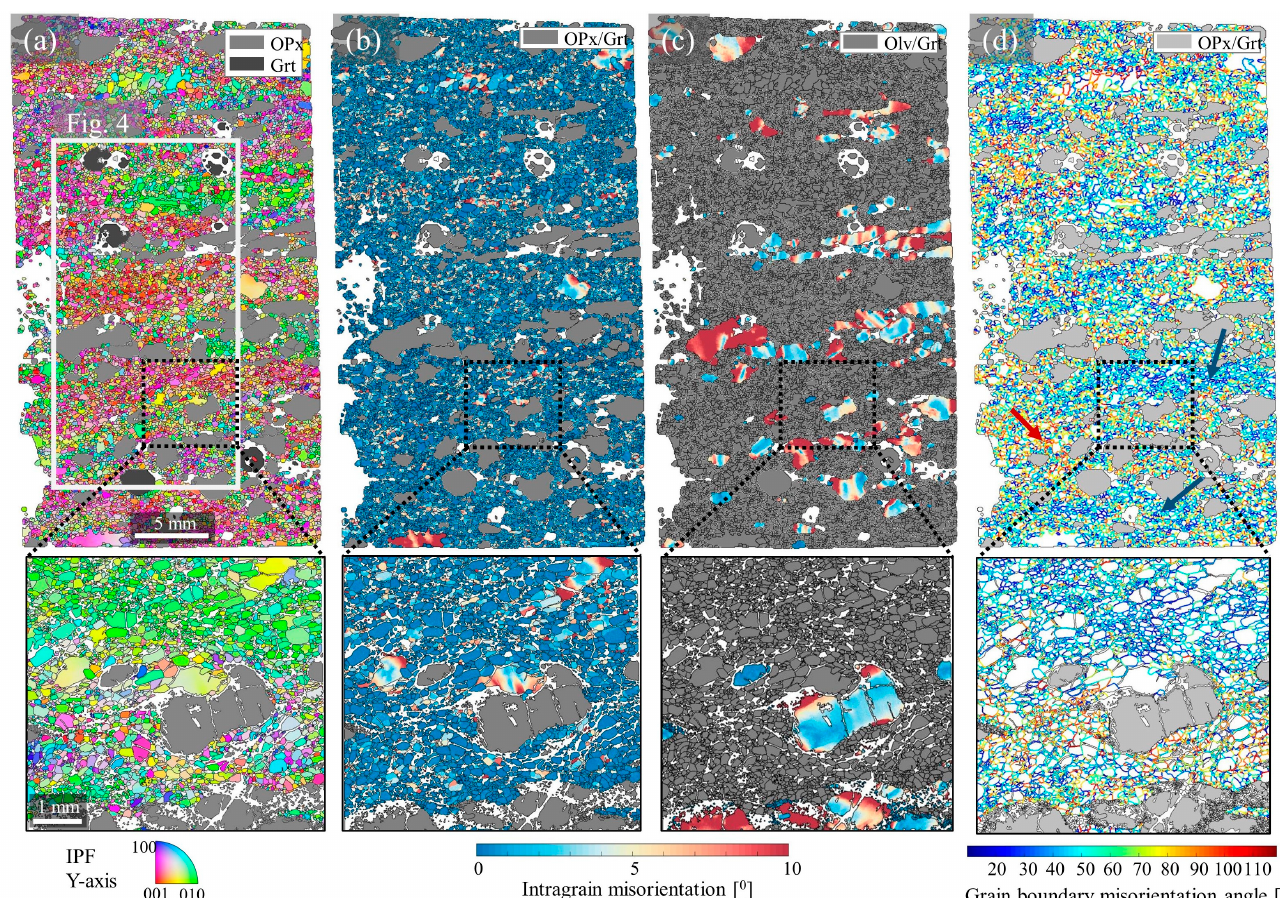
Figure 3. Electron backscatter diffraction (EBSD) map (X-Z plane) presenting four different microstructural characteristics. ( a ) Olivine grain orientations are depicted by the inverse pole figure (IPF) parallel to the Y -axis (i.e., normal to the page). Grains of orthopyroxene (opx) and garnet are colored in grey and dark grey, respectively. ( b ) Intragrain misorientation of olivine grains. Opx and garnet are colored in grey. ( c ) Intragrain misorientation of opx grains. Olivine and garnet grains are in grey. ( d ) Misorientation angle at the boundaries between grains. Notice the bands of low (blue arrow) and high (red arrow) misorientation angles (cold and warm colors, respectively).